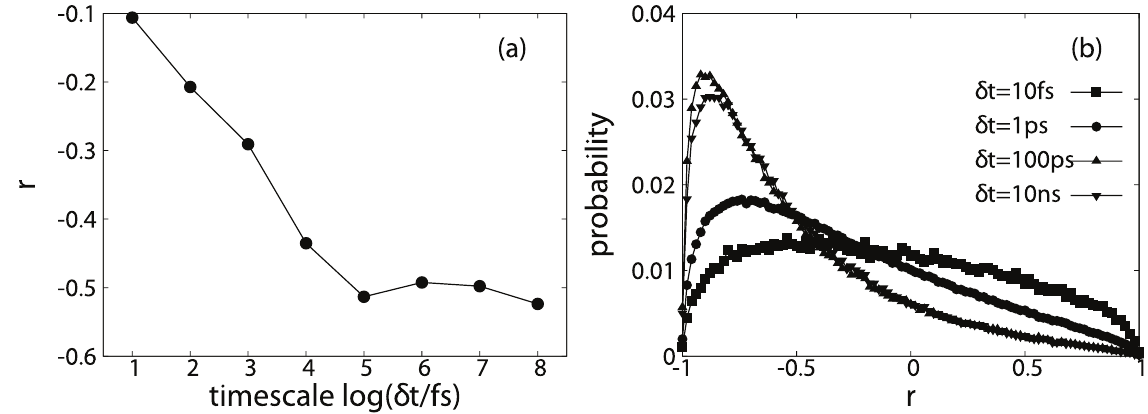
Figure 1. Pearson correlation coefficient r between E p and E p – w for barstar. Time scale values are obtained by first reducing time scales( d t ) with femto-second and then taking logarithm (e.g. 1 corresponds to 10 fs , 2 corresponds to 100 fs , 3 corresponds to 1 ps , etc.) Time scales mentioned in figures hereafter are the same. (a) ensemble average of r as a function of time scales. (b) Distributions of r at 10 fs (square), 1 ps (circle), 100 ps (upwards triangles) and 10 ns (downwards triangles).